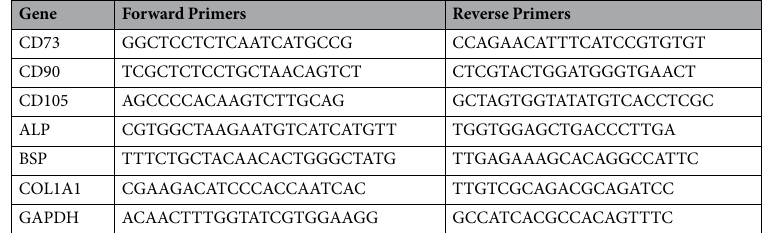
Table 2. PCR analysis: Genes and primer